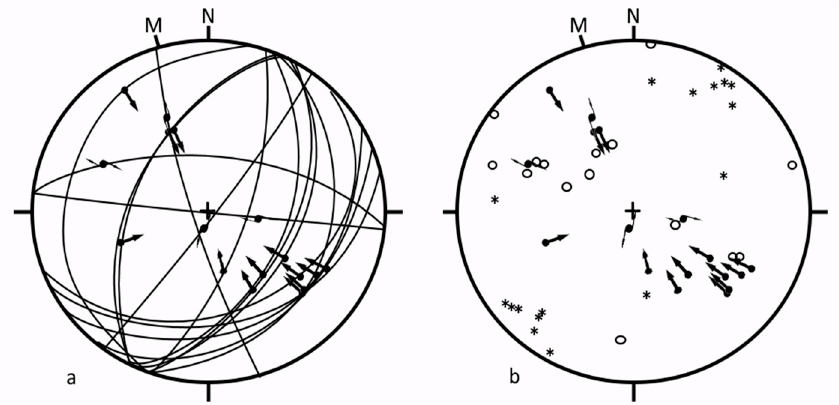
Figure 3. Regime 1. Lower Hemisphere Equal Area projection of ( a ) great circles of fault plane orientation, and ( b ) poles to fault planes (open circles) and (*) the calculated trend and plunge of σ 2. The arrows indicate the rake of slickenlines on the fault planes and point in the direction of slip. Arrows pointing toward the center of the projection indicate compression, those pointing away from the center indicate extension. Solid circles with two arrows pointing in opposite directions indicate the sense of strike-slip movement. Those with no arrowheads have an indeterminant sense of movement. M = magnetic north, N = true north.